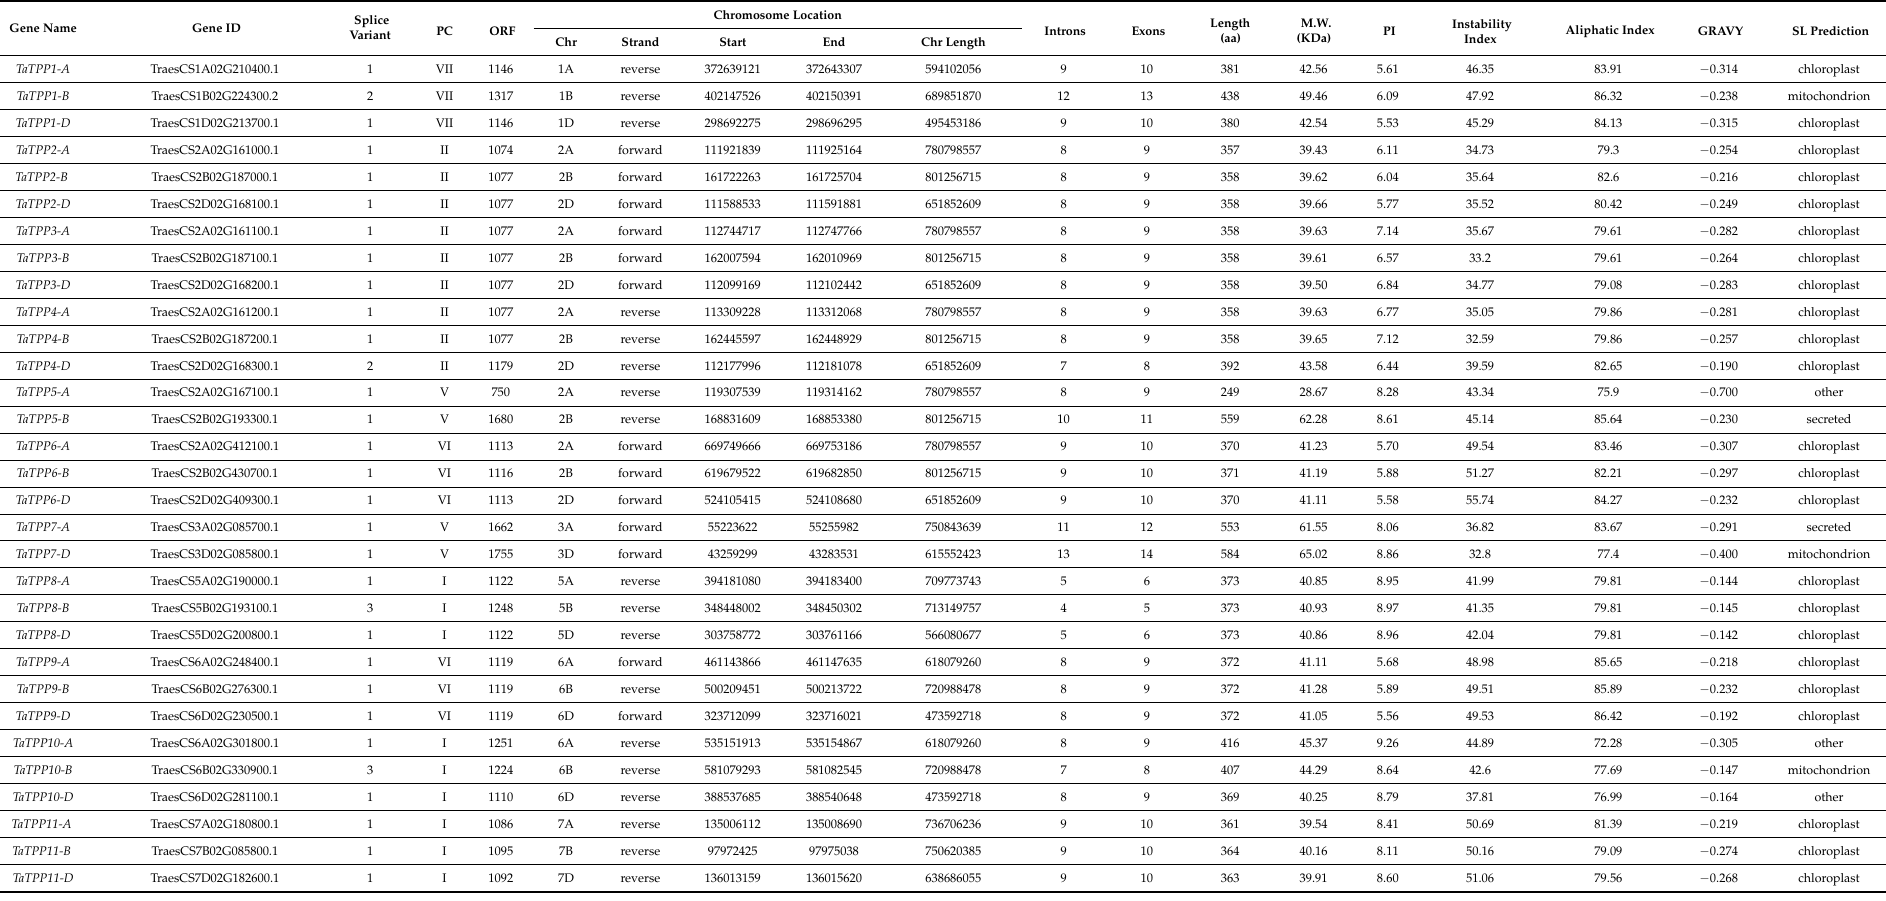
Table 1. Detailed annotations of the TaTPPs in wheat.